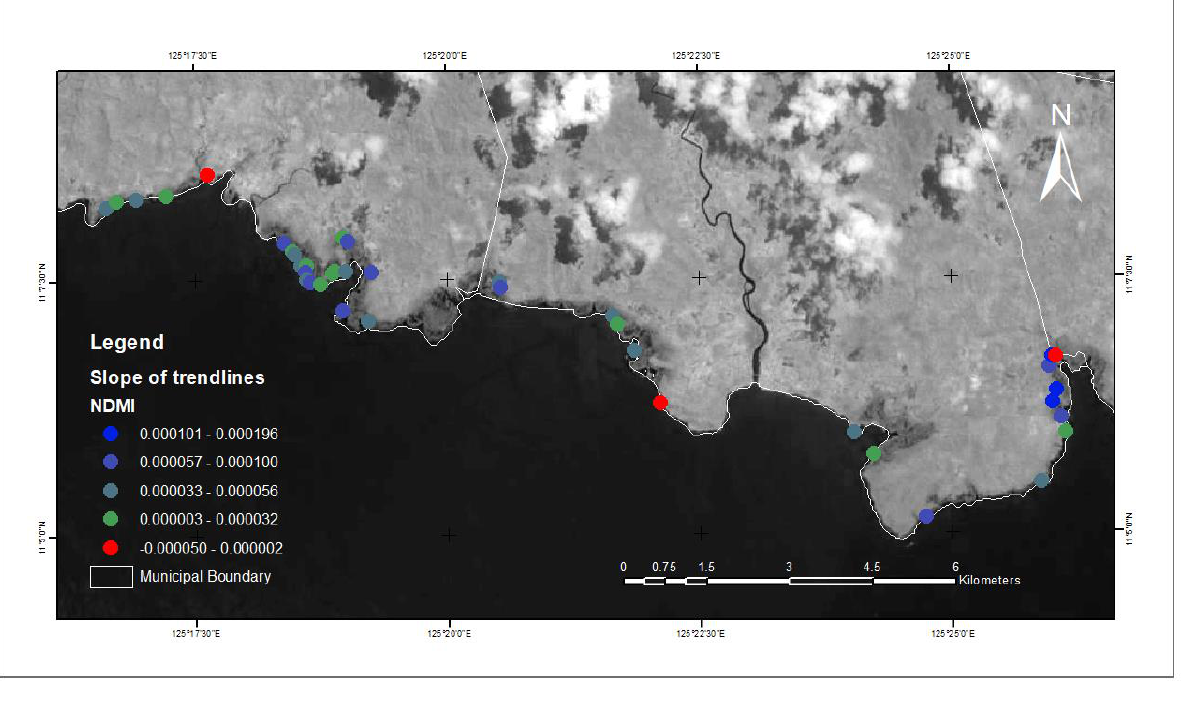
Figure 6: Estimated relative rates of mangrove “recovery” across the study area based on the slope of NDMI trend